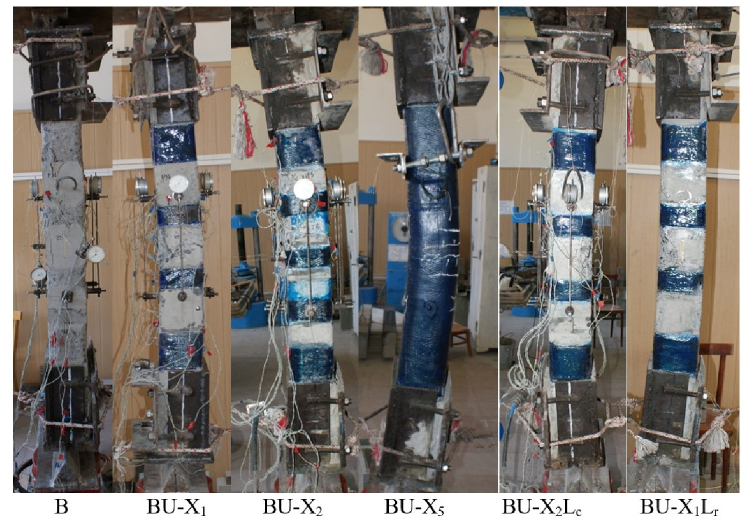
Figure 9. The nature of the destruction of the reference (B) and reinforced (BU) samples with an axial eccentricity of the load application e 0 = 2 cm ( e 0 = 0.16 h).